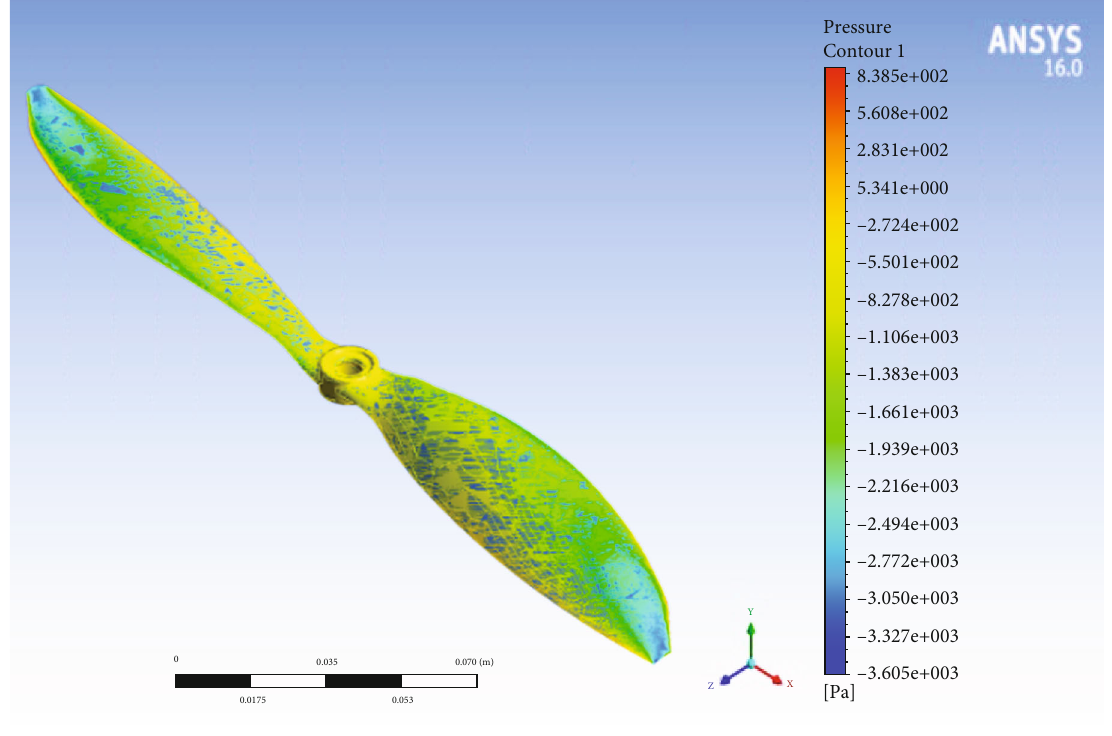
Figure 19: Pressure contour at 0 ° C temperature.